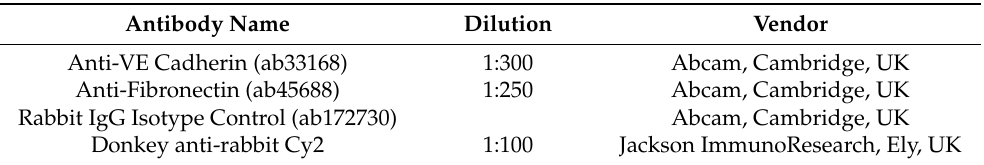
Table 1. Antibodies used for immunofluorescence